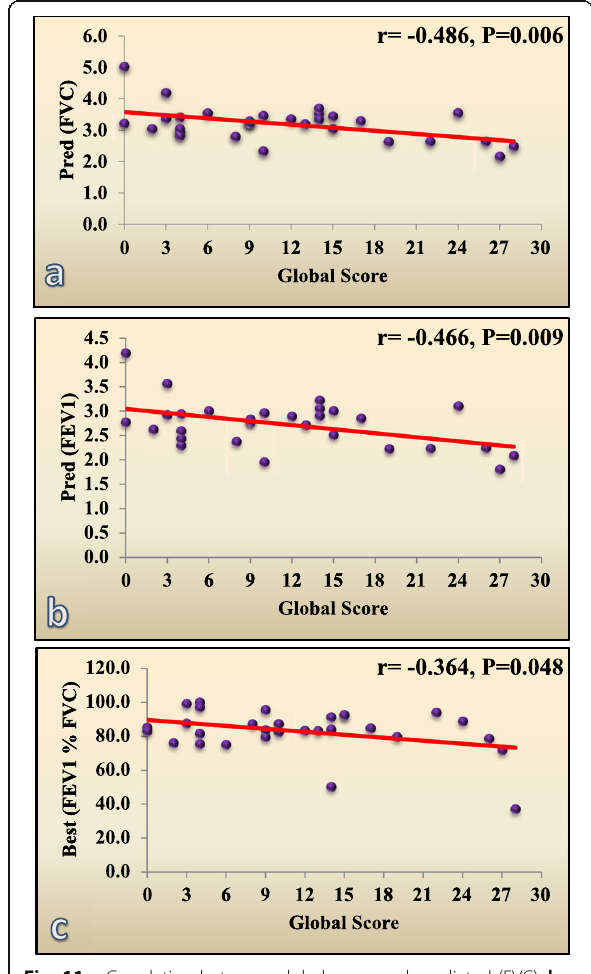
Fig. 11 a Correlation between global score and predicted (FVC). b Predicted (FEV1). c Best